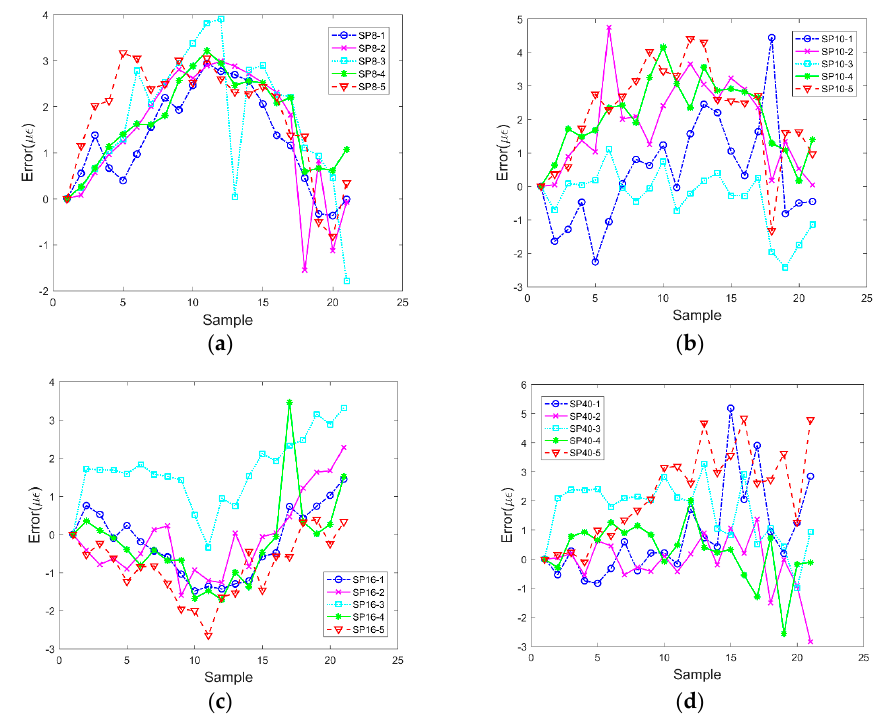
Figure 9. Errors obtained using the data as measured by fiber Bragg grating (FBG) and smartphones with ( a ) 8, ( b ) 10, ( c ) 16, and ( d ) 40